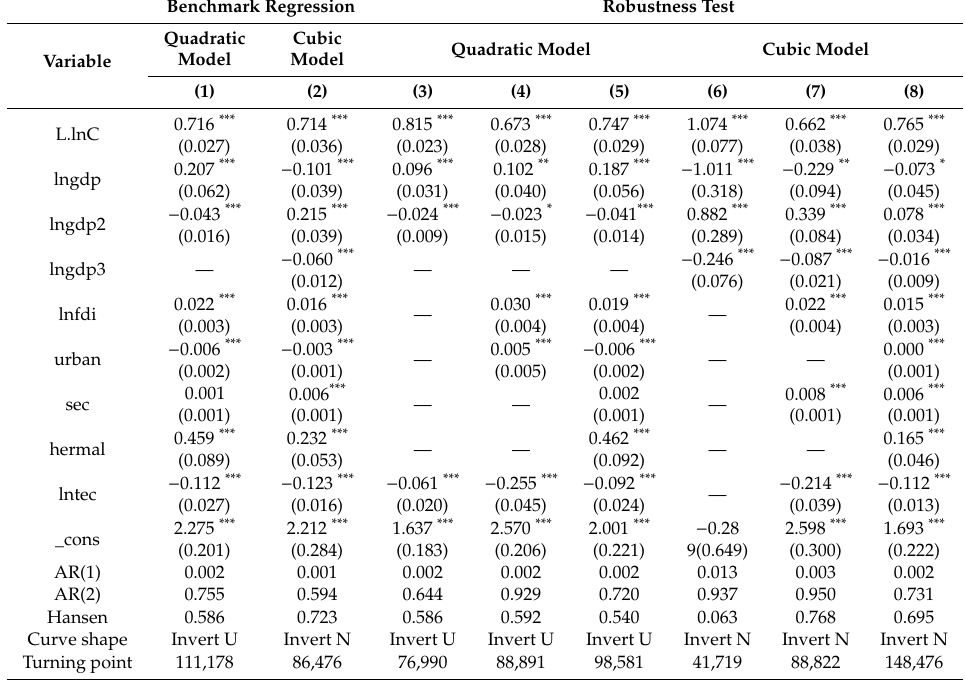
Table 3. Generalized method of moments (GMMs) estimation results of environmental Kuznets curve (EKC) relationship for per capita CO 2 emissions with di ff erent specifications and estimation